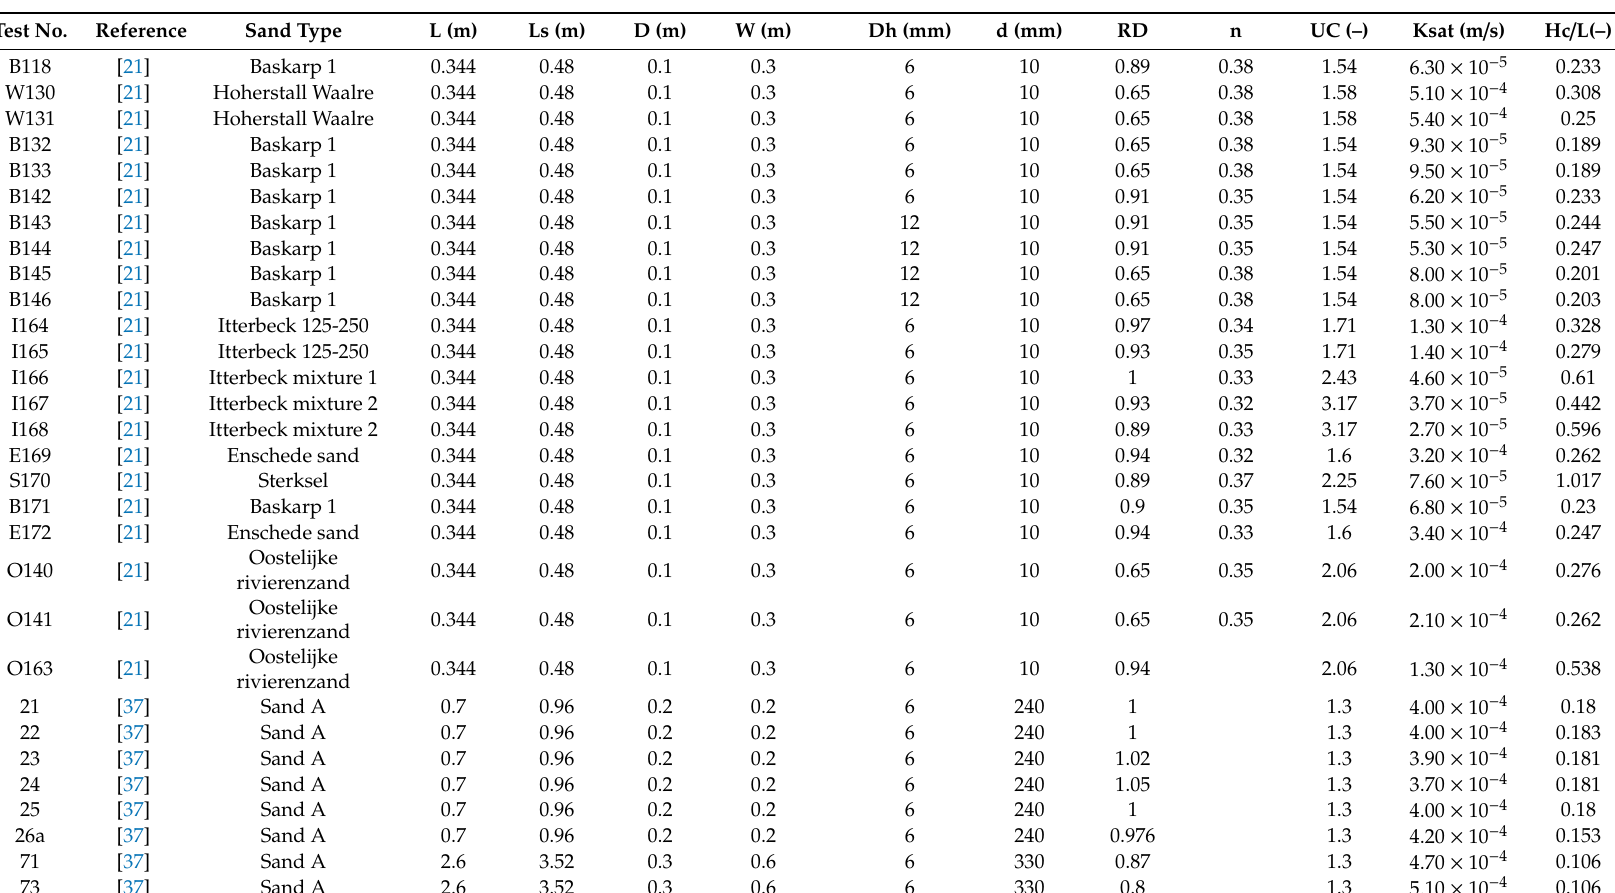
Table A1. Data on hole type piping experiments as reported in Van Beek, 2015a and Van Beek 2015. Experiment dimensions of some of these tests di ff er from the experiment used in this study. L is the distance to the exit hole from the inlet, Ls is the inside length, D, the thickness and W the width of the experiment container. D is the thickness of the acrylic plate. Dh is the diameter of the outflow point and d is the thickness of the acrylic plate. RD is the relative density, n is the porosity. Test